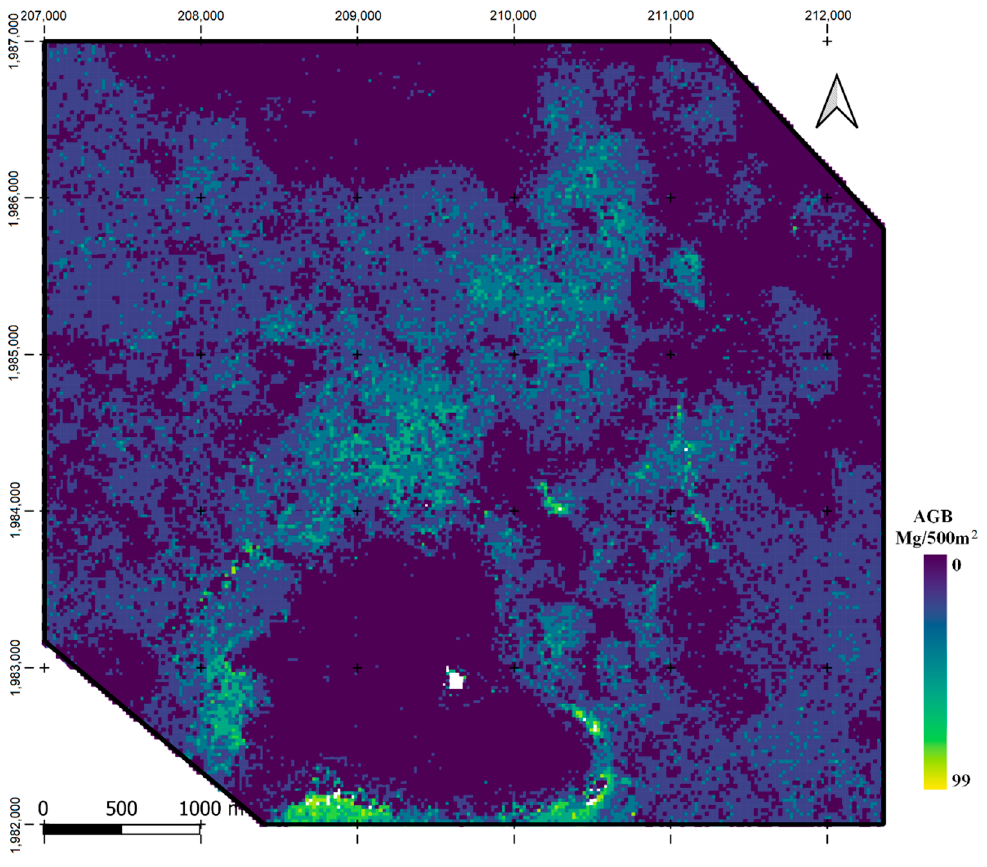
Figure 6. Above ground biomass AGB Mg/500 m 2 . White area corresponding to wetland was excluded from AGB